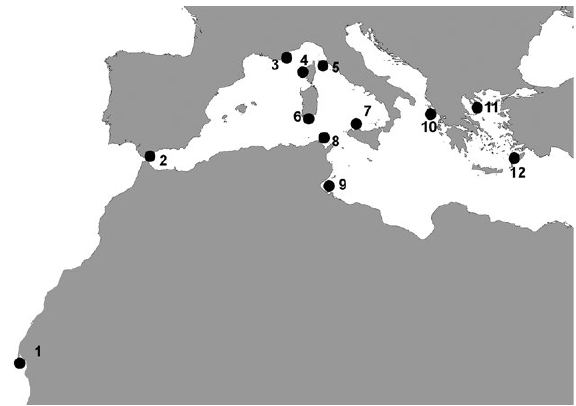
Fig. 1. – Map showing sampling sites where molecular material was obtained (see Table 1 for details). 1, Cap Tafarit, Mauritania. 2, Tarifa Island, Spain. 3, Saint Raphaël, France. 4, Calcataggio, Cor- sica. 5, Elba Island, Italy. 6, Su Siccu, Sardinia. 7, Palermo, Sicily. 8. Bizerte, Tunisia. 9, Djerba Is., Tunisia. 10, Paxos Is., Greece. 11, Marmaros, Halkidiki, Greece. 12, Astypalea Is.,